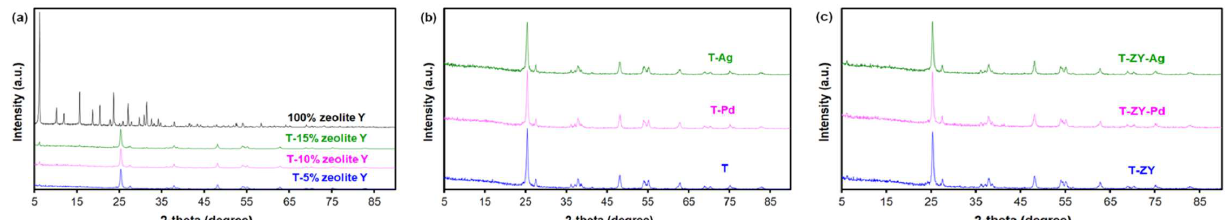
Figure 1. The XRD patterns of ( a ) the powders: zeolite Y and the mixtures of TiO 2 and zeolite Y containing 5, 10 and 15 wt.% of zeolite; ( b ) TiO 2 before and after deposition of metal nanoparticles (Pd or Ag); and ( c ) a mixture of TiO 2 and 5 wt.% zeolite Y before and after deposition of metal nanoparticles (Pd or Ag).